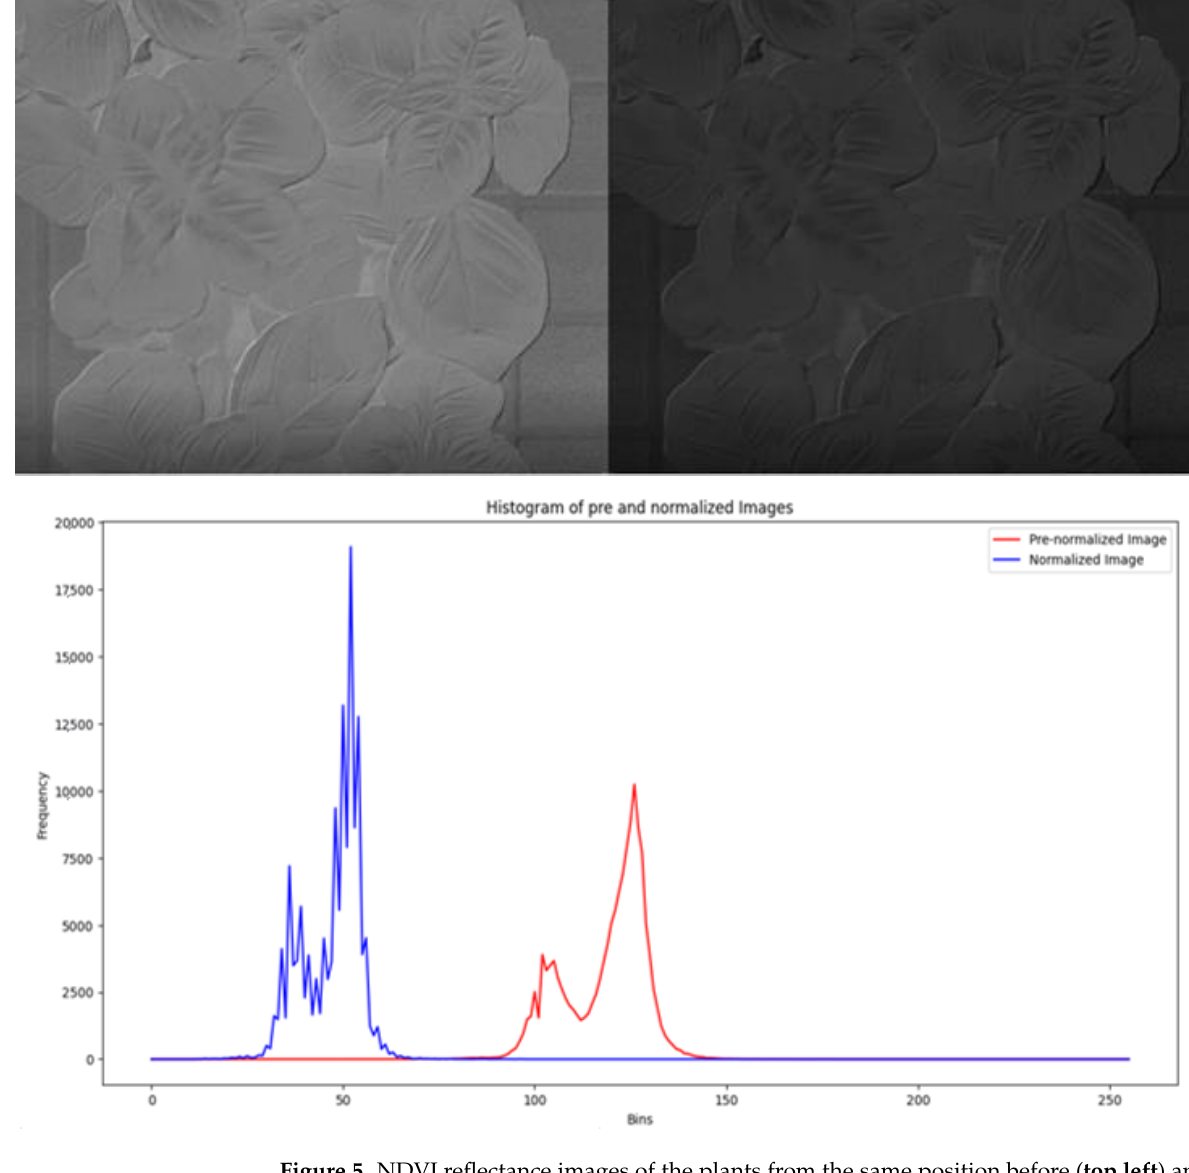
Table 2. Matrix of data of the patches that were developed in order to calculate the average reflec- tance of plants in different leaf areas for the three different image locations in each of the three different treatments.